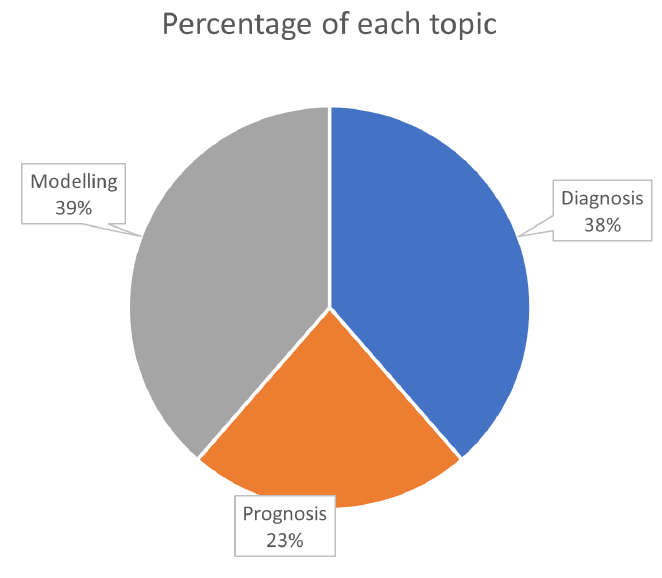
Figure 3. Publications’ distribution according to their fields.